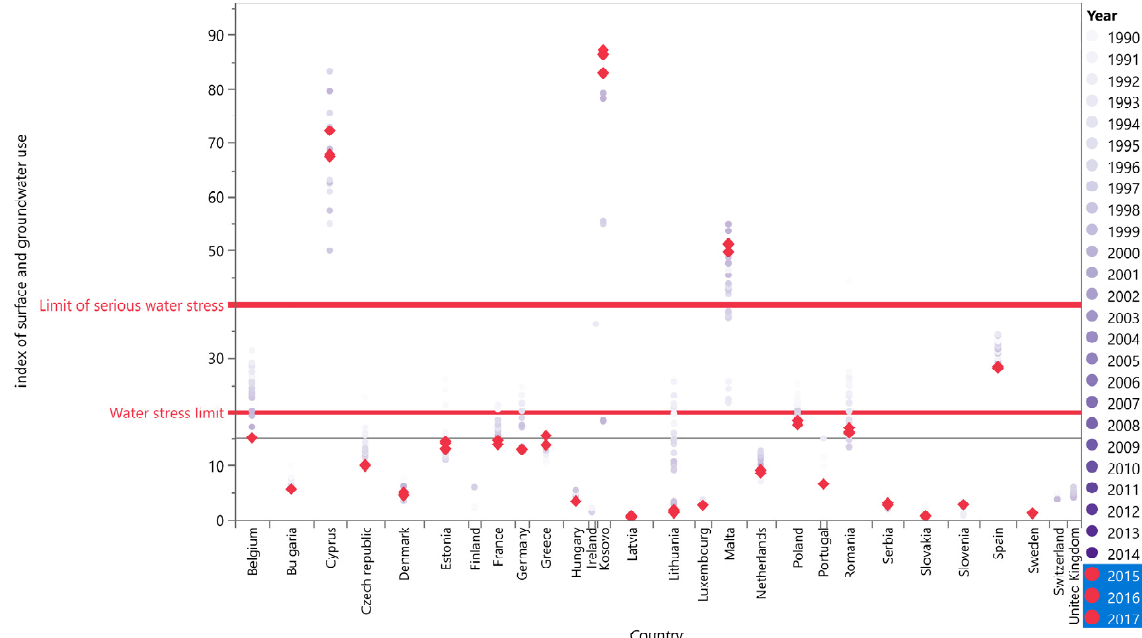
Figure 4. Comparing of EU member states–index of underground water use (%) in 1990–2017.